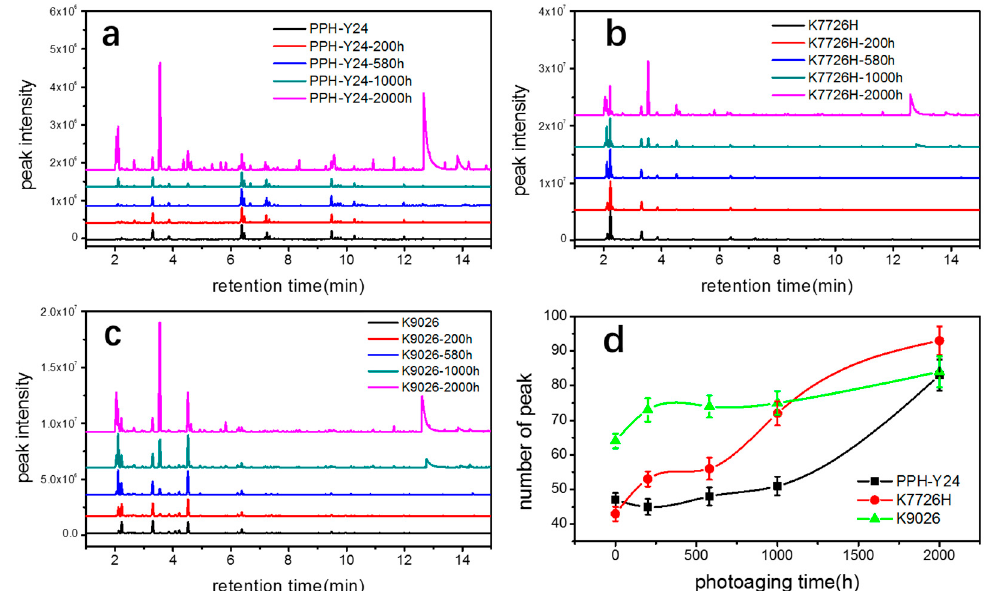
Figure 3. VOC chromatogram of three kinds of PP resin (( a ) K7726H, ( b ) K9026, ( c ) PPH-Y24) and the number of chromatogram peak ( d ) with various accelerated photo aging exposure time.